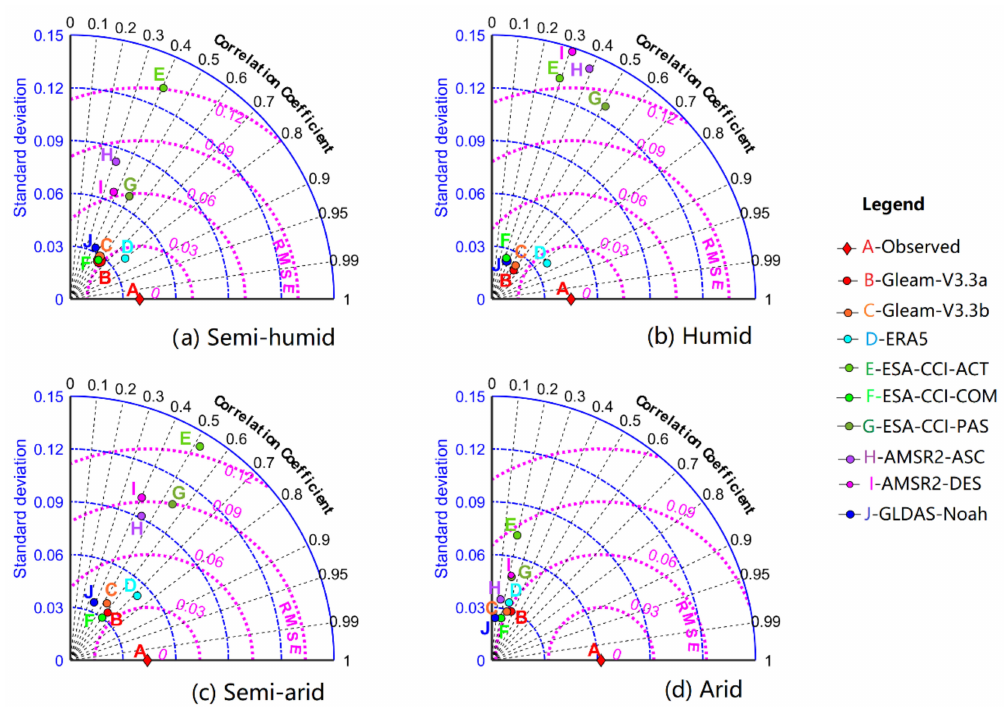
Figure 3. Taylor diagrams comparing the temporal performances of nine multi-source satellite SM products against the ground-observed SM series in semi-humid, humid, semi-arid and arid areas (note that herein, RMSE denotes the centered root mean squared error (RMSE), which is calculated after subtracting the mean value).